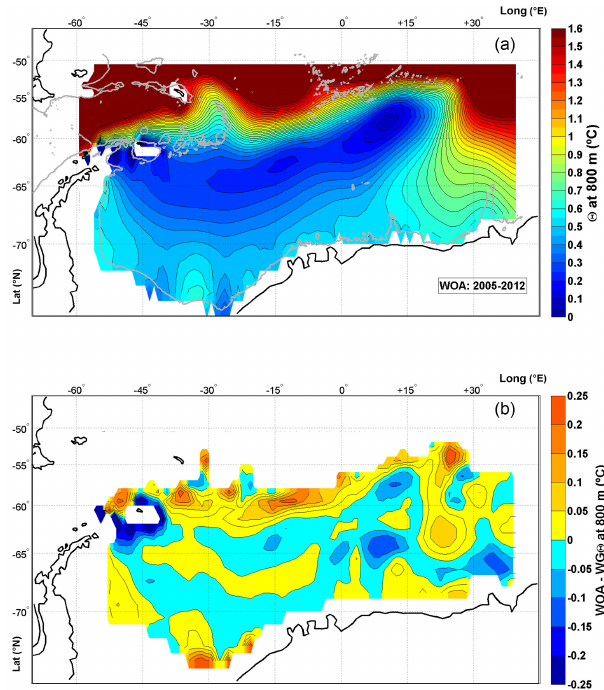
Figure 24. Conservative temperature ( ◦ C) at 800m from the WOA13 climatology during 2005 to 2012. (i.e. WOA0512 in Fig. 23). Panel (b) shows the difference with the entire time span of the data set provided, i.e. WOA0512 minus WG_all. The grey contour shows the 2000m